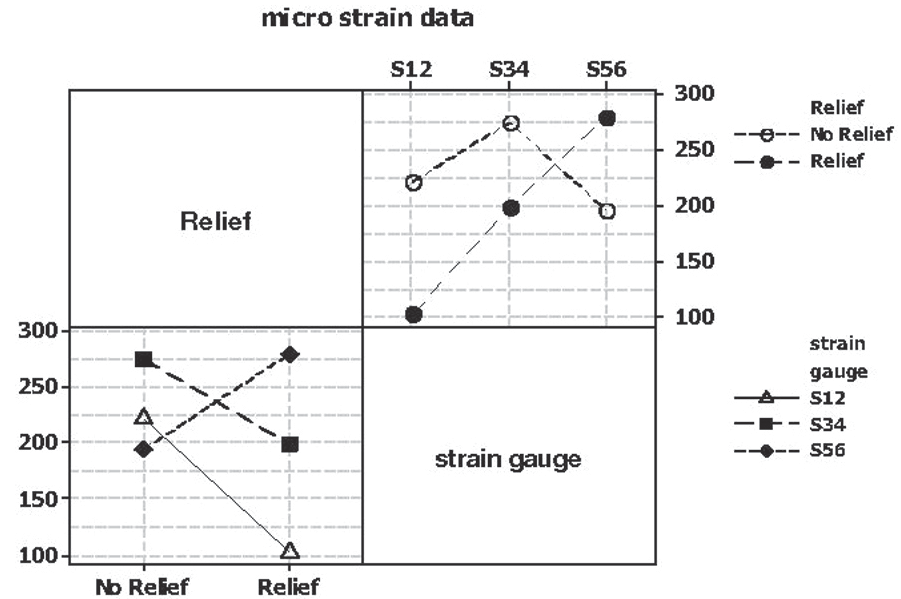
FIGURE 4- Plot of microstrain means values (µ å ) by six experimental